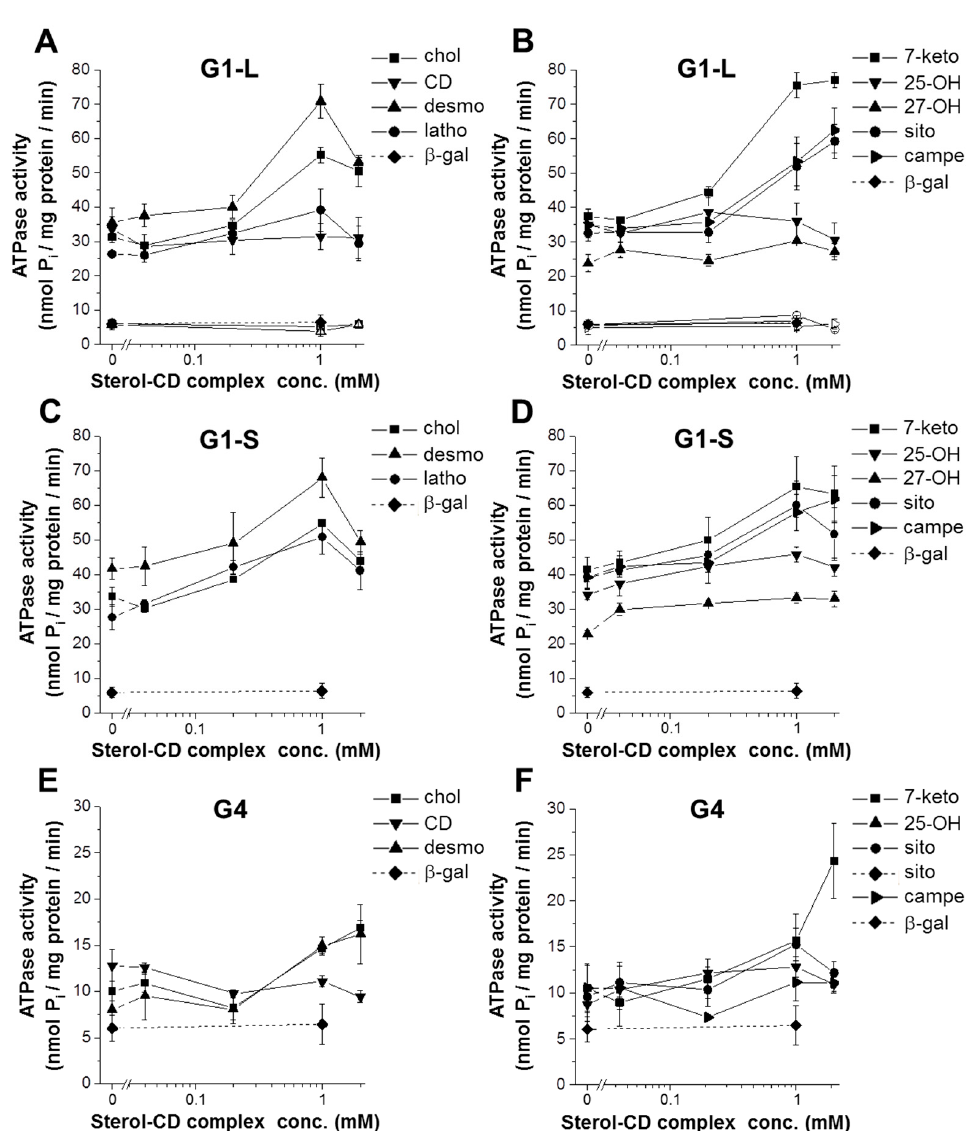
Figure 1. Interaction of various sterol compounds with ABCG1 isoforms and ABCG4. Dose response curves show the vanadate-sensitive ATPase activity of membrane preparations containing the long ( A , B ) or the short ( C , D ) isoforms of ABCG1, or ABCG4 ( E , F ). Open symbols in Panels ( A , B ) indicate the activities obtained with membranes containing the catalytic site mutant variant of the long isoform of ABCG1. Membranes containing β -galactosidase ( β -gal) served as a negative control. The samples were pre-treated with the indicated sterol compounds at various concentrations or the vehicle (methyl- β -cyclodextrin—CD). chol—cholesterol; desmo—desmosterol; latho—lathosterol; 7-keto—7-ketocholesterol; 25-OH—25-hydroxycholesterol; 27-OH—27-hydroxycholesterol; sito— β -sitosterol;